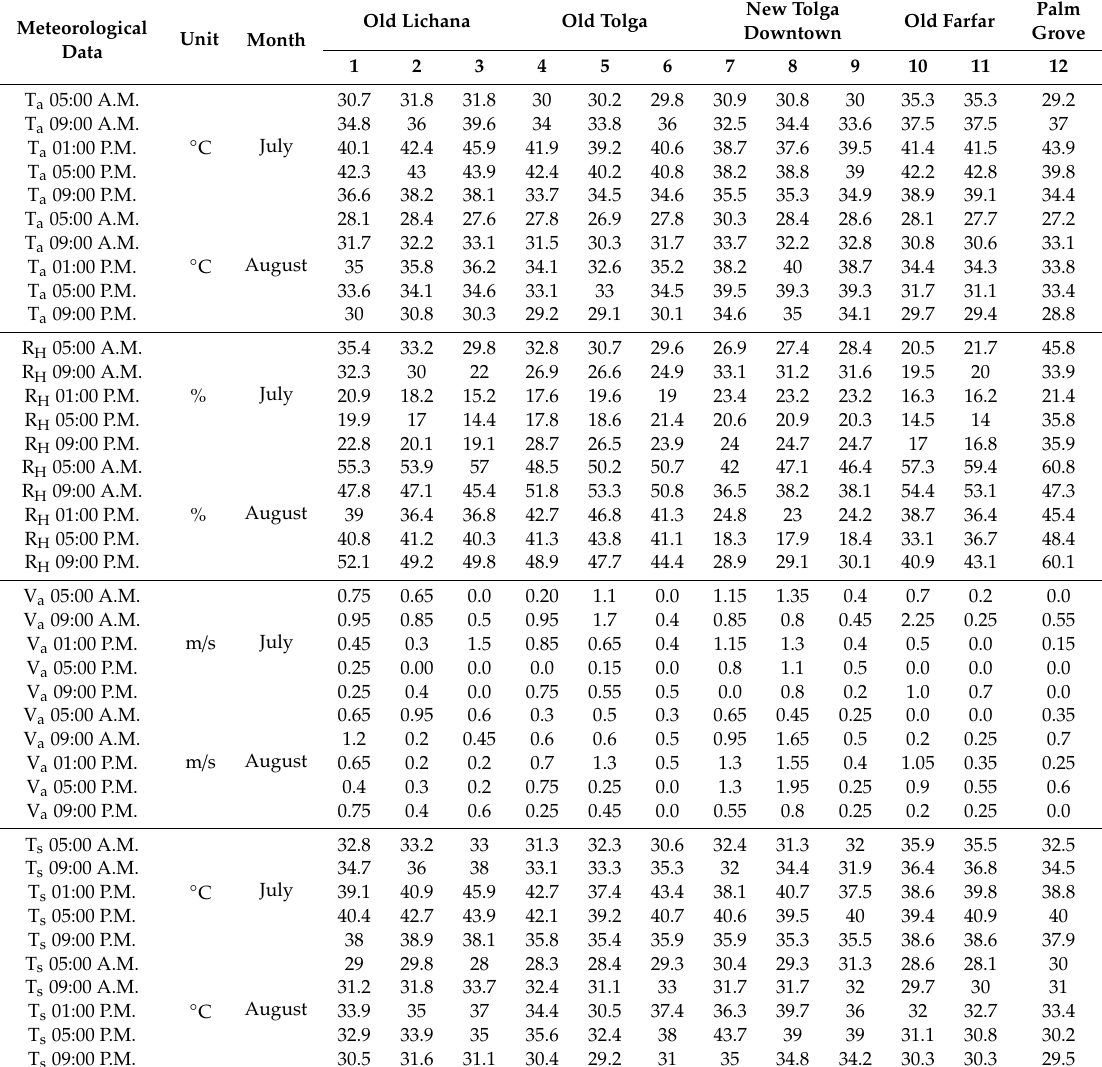
Table 3. Summary of meteorological data input in